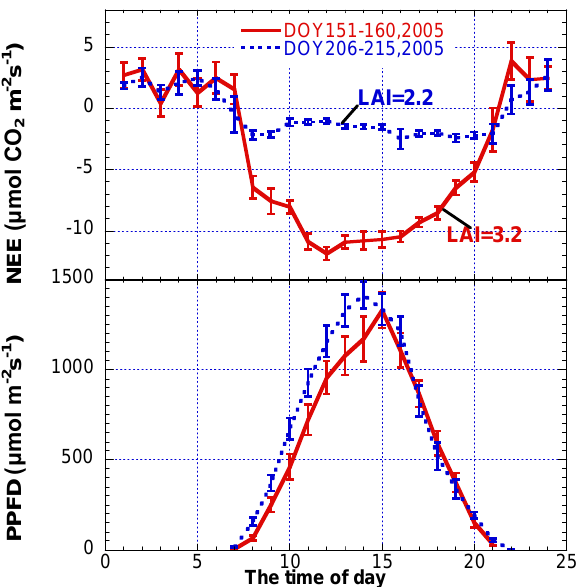
Fig. 9. Examples of 10-day binned diurnal variations in CO 2 flux ( NEE ) and photosynthetic photon flux density ( PPFD ) during growing periods. (DOY151–160, and DOY206–215, 2005.) LAI was around 2.2 and 3.2, respectively. Error bars represent the standard deviation.